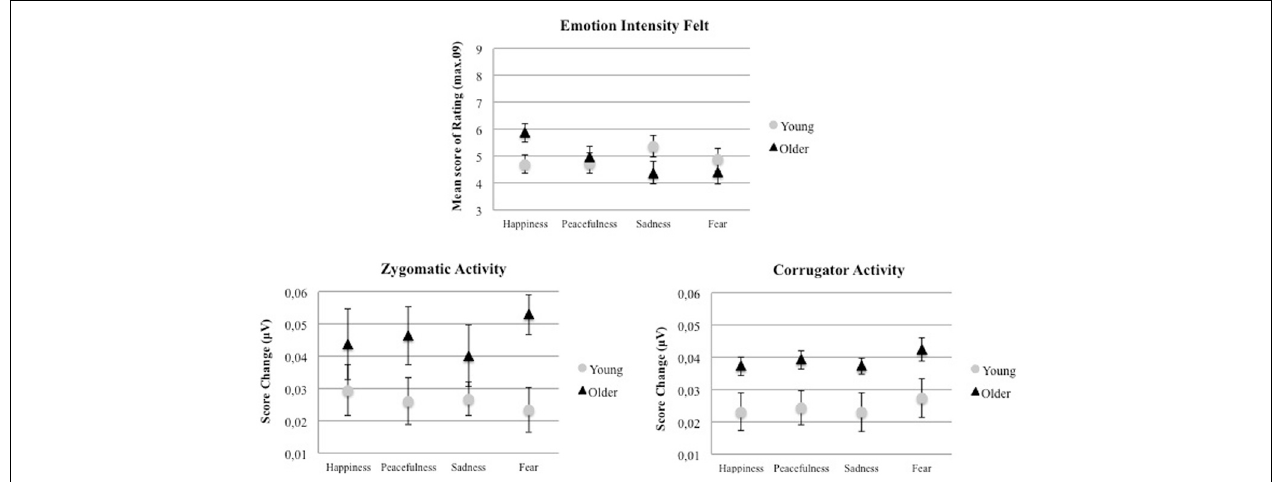
FIGURE 1 | Mean score and standard error of emotion intensity felt, zygomatic and corrugator muscle activity as a function of intended emotions (happiness, peacefulness, sadness, fear) and age group (younger adults, older adults).